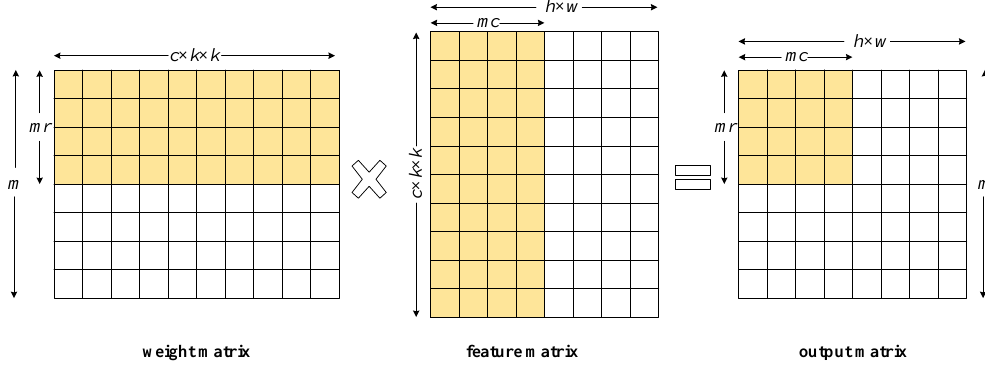
Figure 4. Partitioning weight and feature matrices to blocks to adapt to the 2D multiply and accumulate (MAC) array.